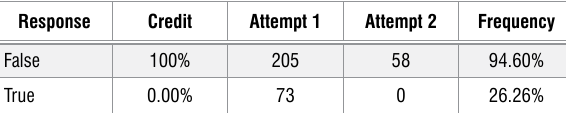
Analysis of student responses for Question 1 ( n = 278) response